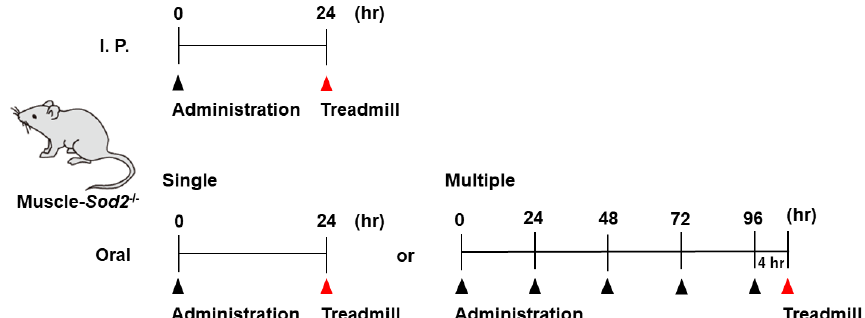
Figure 1. Schematic illustration of the administration and treadmill experiments. We administrated substances by I. P. injection ( top ) or orally ( bottom ) to the muscle- Sod2 -/- mice, followed by treadmill running.